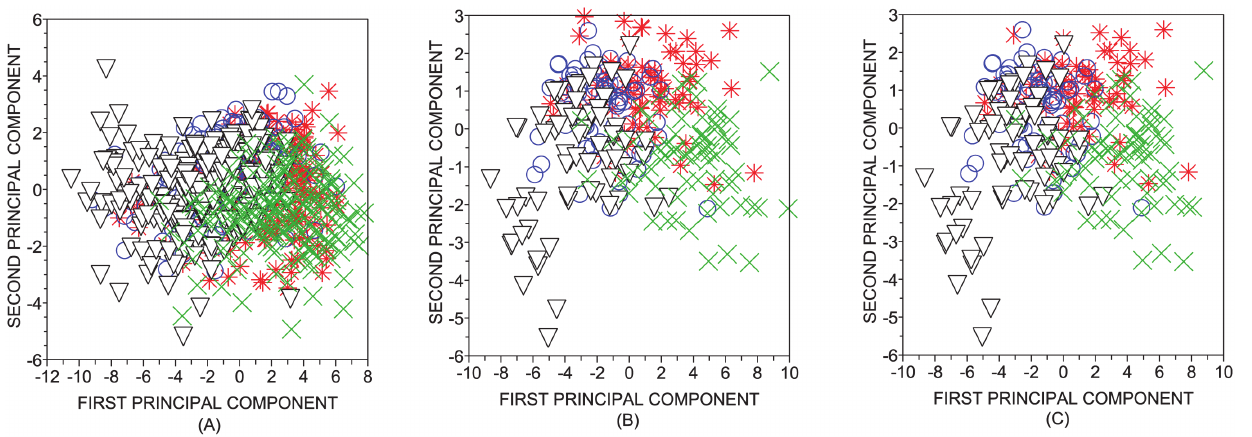
Fig 3. Visualization of the projection of the eleven attributes employed for the classification of authorship. The principal component analysis was employed. The length of the subtexts considere for the purpose of authorship recognition were: (a) W = 500; (b) W = 1,000; and (c) W = 1,500. Note that the discriminability increases as the subtexts become